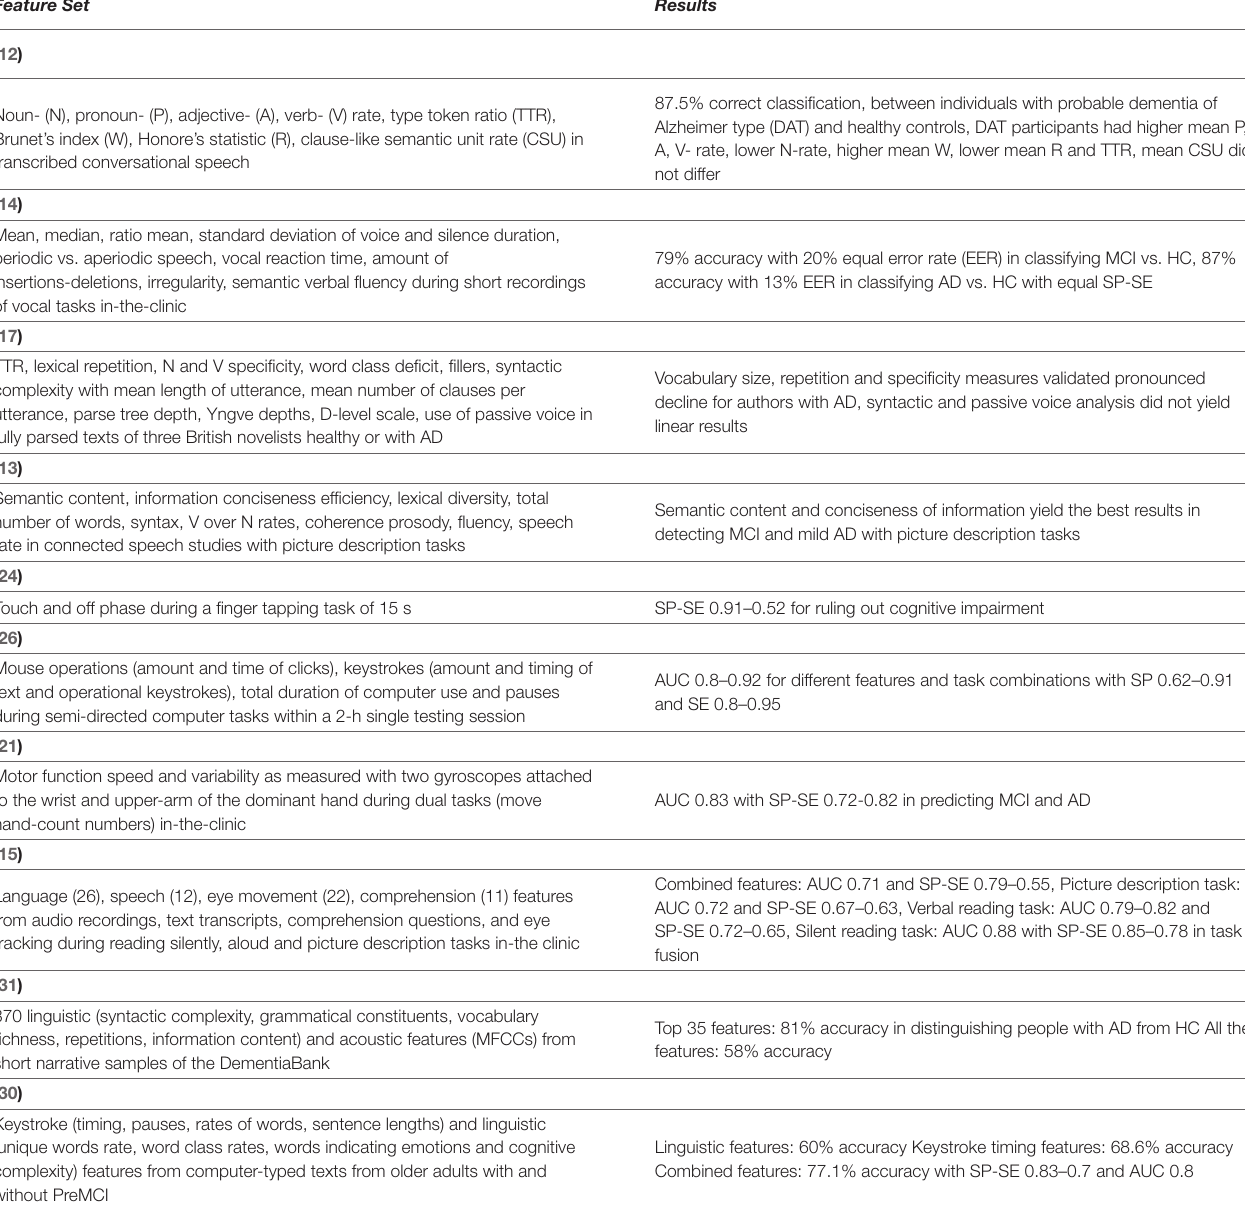
TABLE 1 | References, feature sets, and results of studies regarding MCI and AD detection based on speech or motor deficiency-related features and multimodal data. Feature Set Results